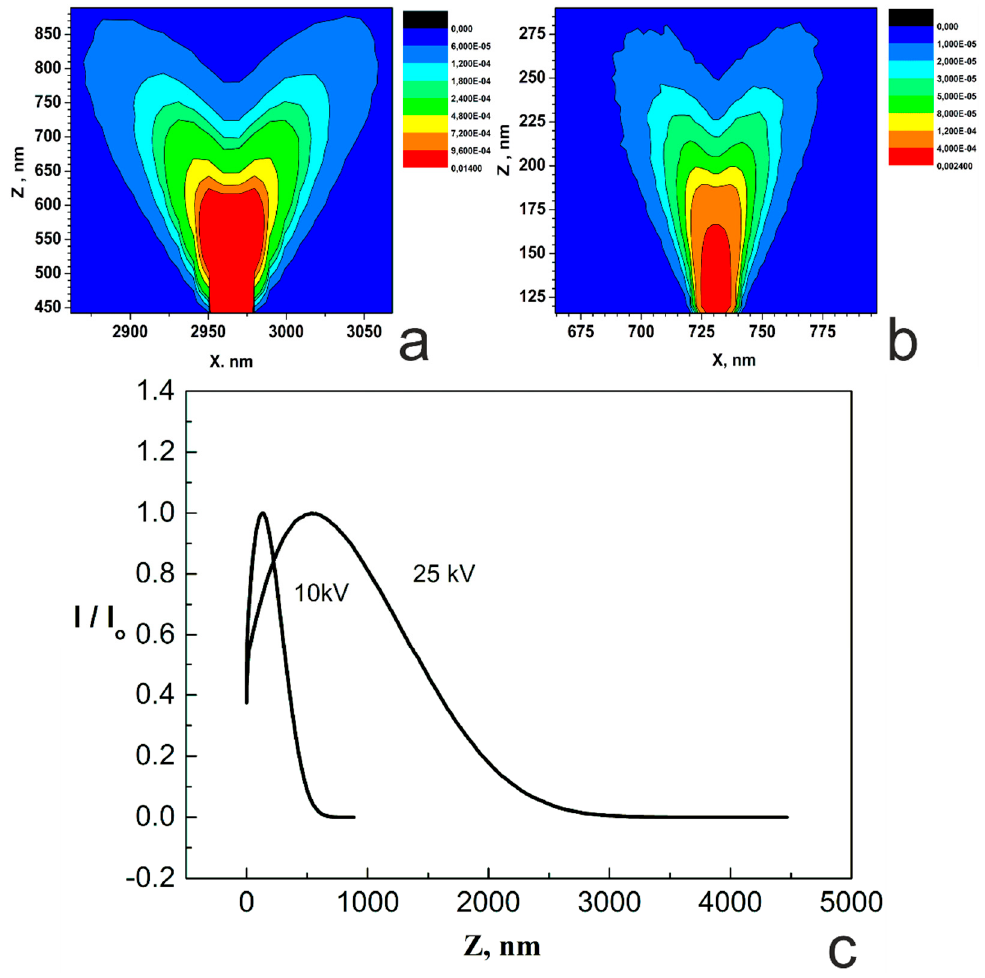
Figure 3. The spatial distribution of EB energy deposition rate ( a , b ) and the normalized profiles of electron energy losses over the depth ( c ) in SBN for 25 and 10 kV. Coatings 2020 , 10 , x FOR PEER REVIEW